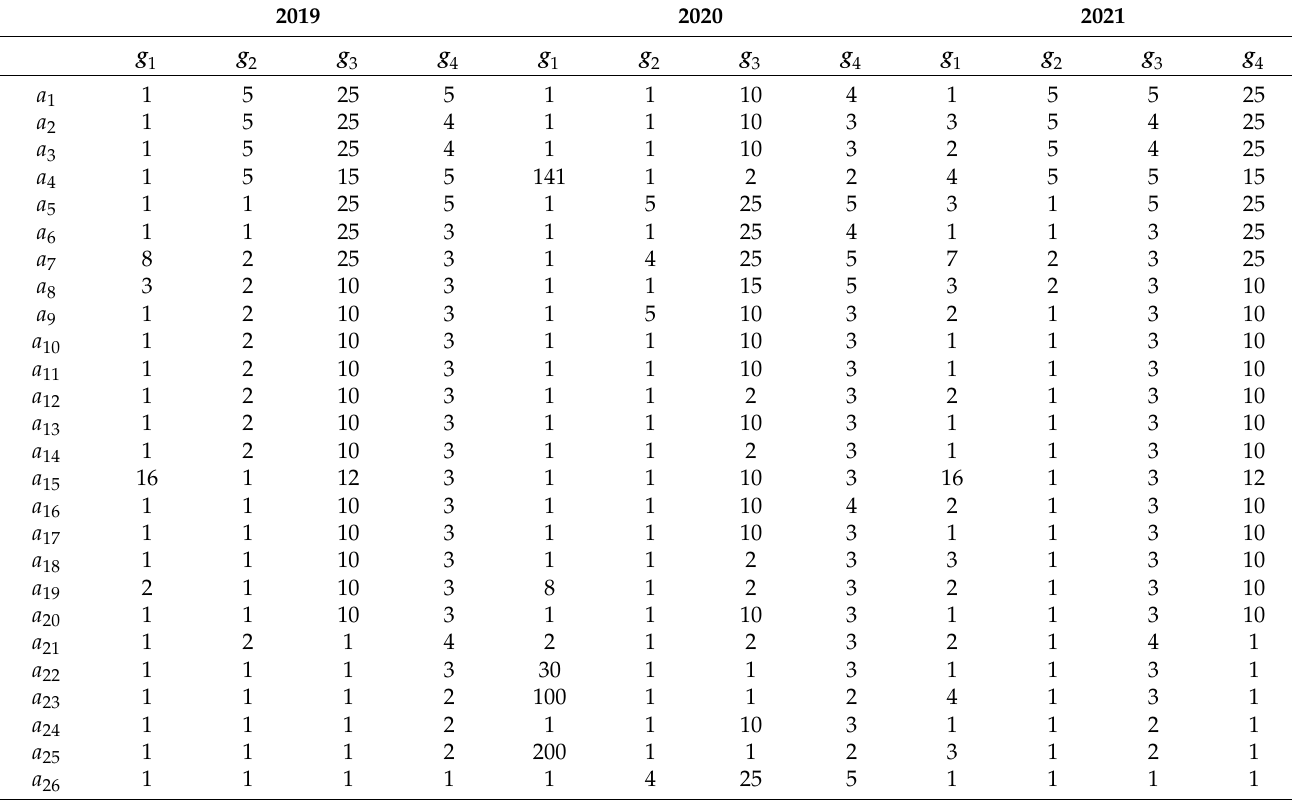
Table 1. Evaluation r j ( a i ) for errors occurs in 2019, 2020 and 2021.